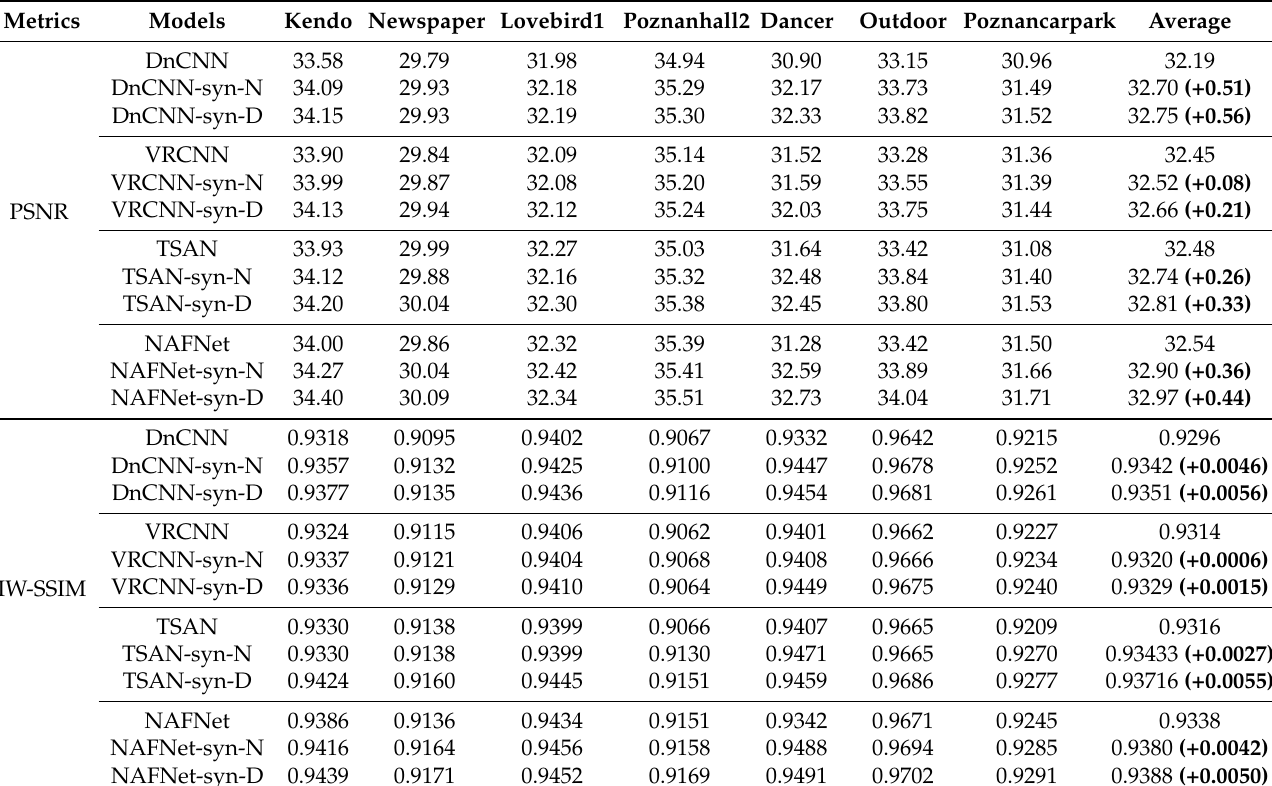
Table 6. SVQE comparison measured by image quality metrics among DnCNN-, VRCNN-, TSAN-, NAFNet-based schemes by pre-training on synthetic databases from NYU and DIV2K on Seqs-H.264. Model (DnCNN, VRCNN, TSAN, NAFNet) represents the baselines, and model-syn-N/D represents the existing models (DnCNN, VRCNN, TSAN, NAFNet) combined with transfer learning scheme using our proposed synthetic images. The performance gains of the proposed model-syn-N/D over model are highlighted in bold.